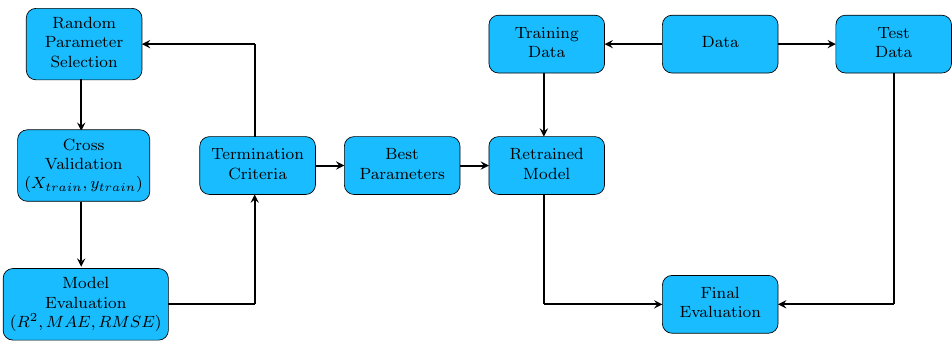
Figure 7. The scheme of cross-validation process with randomized hyper-parameter search using various evaluation metrics ( R 2 , MAE , and RMSE ) with final evaluation on the test